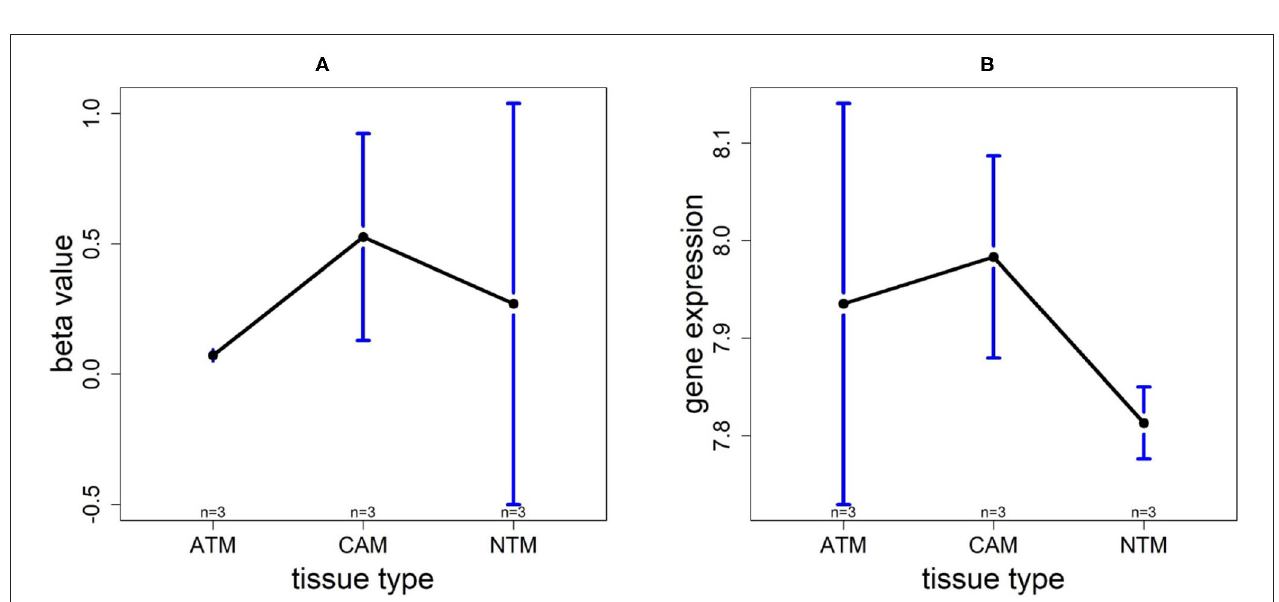
FIGURE 8 | Survival analysis in FOXP2. (A) Depicts the histogram of FOXP2 gene expression. From TCGA-STAD dataset, we set 1 as the gene expression threshold to separate the 238 observations into two groups: low expression and high expression groups of samples. (B) Shows the estimated survival function plots using a Cox proportional hazard regression analysis between the two groups; FDR p -value = 0.0338 indicates a significant survival time difference between the two groups.